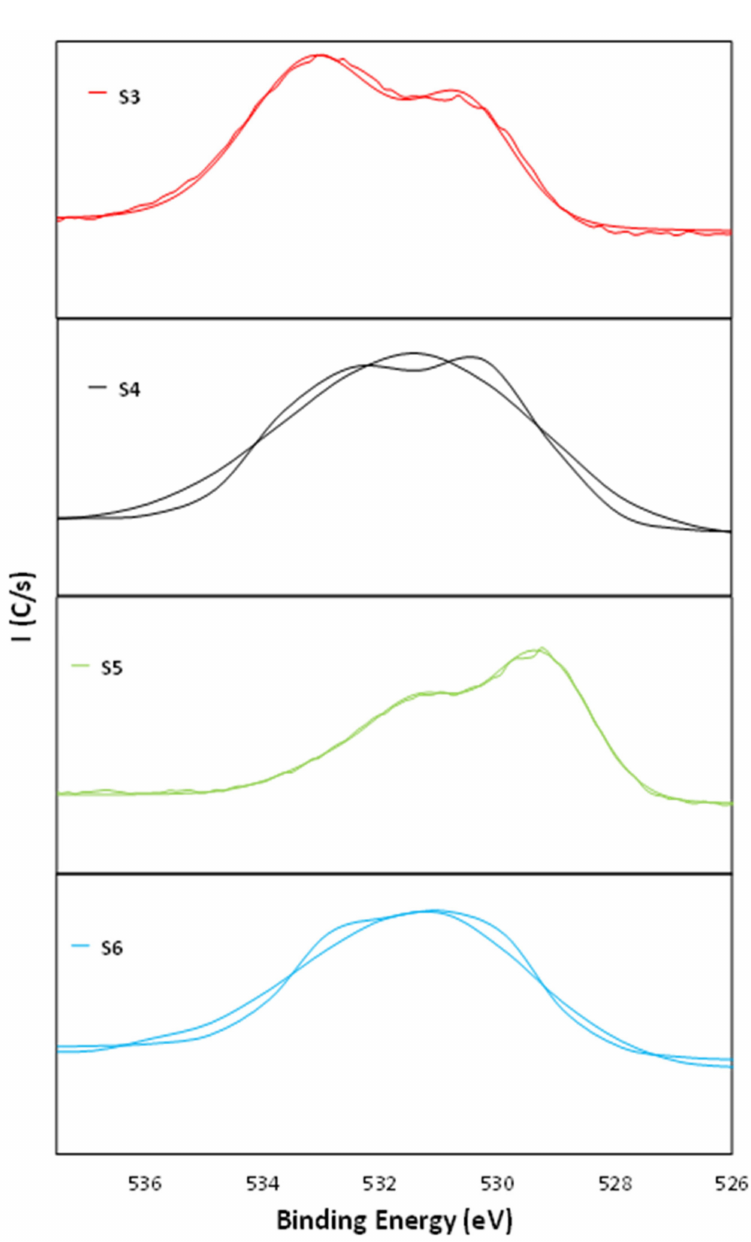
Figure 7. XPS spectra with different contributions of O1s for the samples S3, S4, S5, and S6. Table 4. Ion migration values from different sample